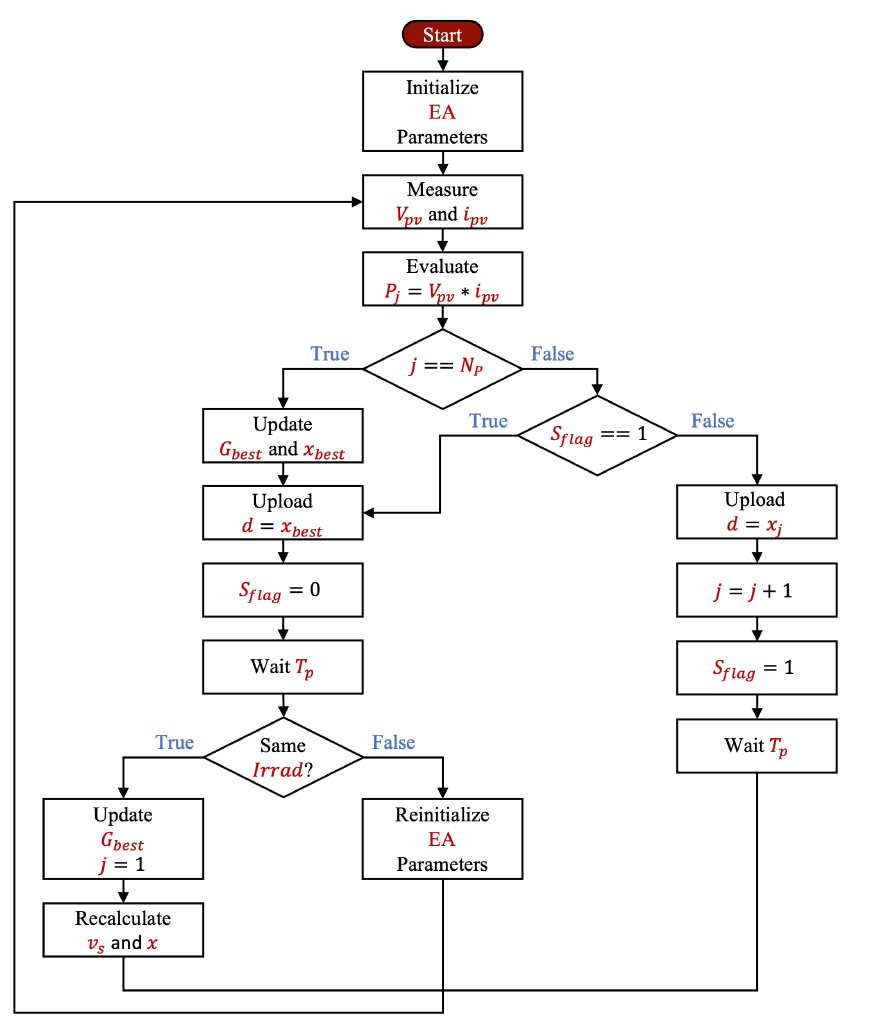
Figure 8. Basic flowchart structure of the